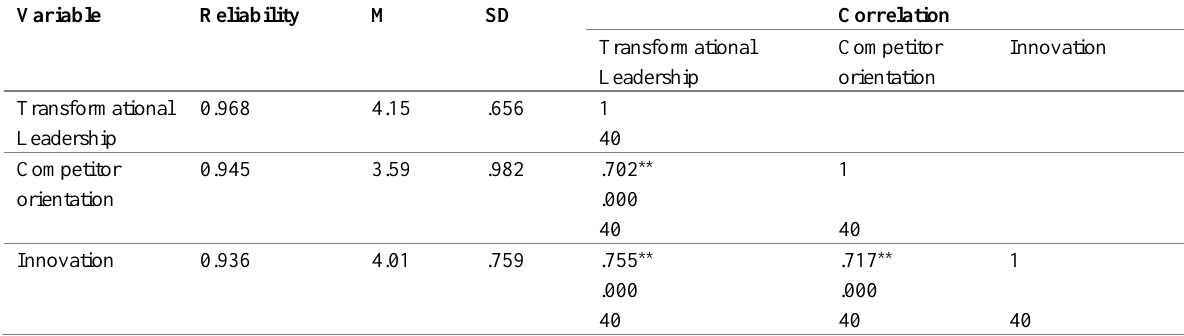
Table 2: Results on Reliability, Means, Standard Deviations and Correlation of the Study